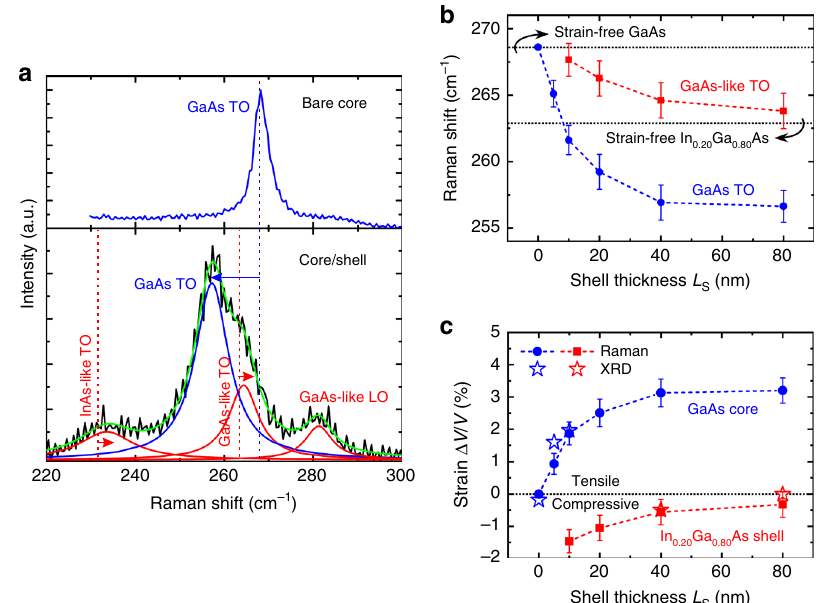
Fig. 2 Strain analysis of GaAs/In 0.20 Ga 0.80 As core/shell nanowires as a function of shell thickness L S . a Raman scattering spectra at 300 K from a single core nanowire without shell ( “ bare core ” ) and a single core/shell nanowire with L S = 40 nm ( “ core/shell ” ). Phonon peaks in blue are attributed to the core, whereas the ones in red belong to the shell. The cumulative fi t curve is shown in green and the strain-free values of phonons with vertical dashed lines. The arrows indicate the strain-induced shift of the various transverse optical (TO) phonons. b Raman shift of the GaAs (blue data points) and the GaAs-like (red data points) TO phonons as a function of L S . The dashed lines are guides to the eye, whereas the horizontal dotted lines show the expected Raman shift of GaAs and GaAs-like TO phonons in strain-free GaAs and strain-free In 0.20 Ga 0.80 As, respectively. The error bars represent the standard deviation and the instrument error. c The hydrostatic strain in the core (blue data points) and the shell (red data points) as a function of L S . The dashed lines are guides to the eye. The error bars originate from the error bars in Raman shift. The star symbols correspond to X-ray diffraction (XRD)